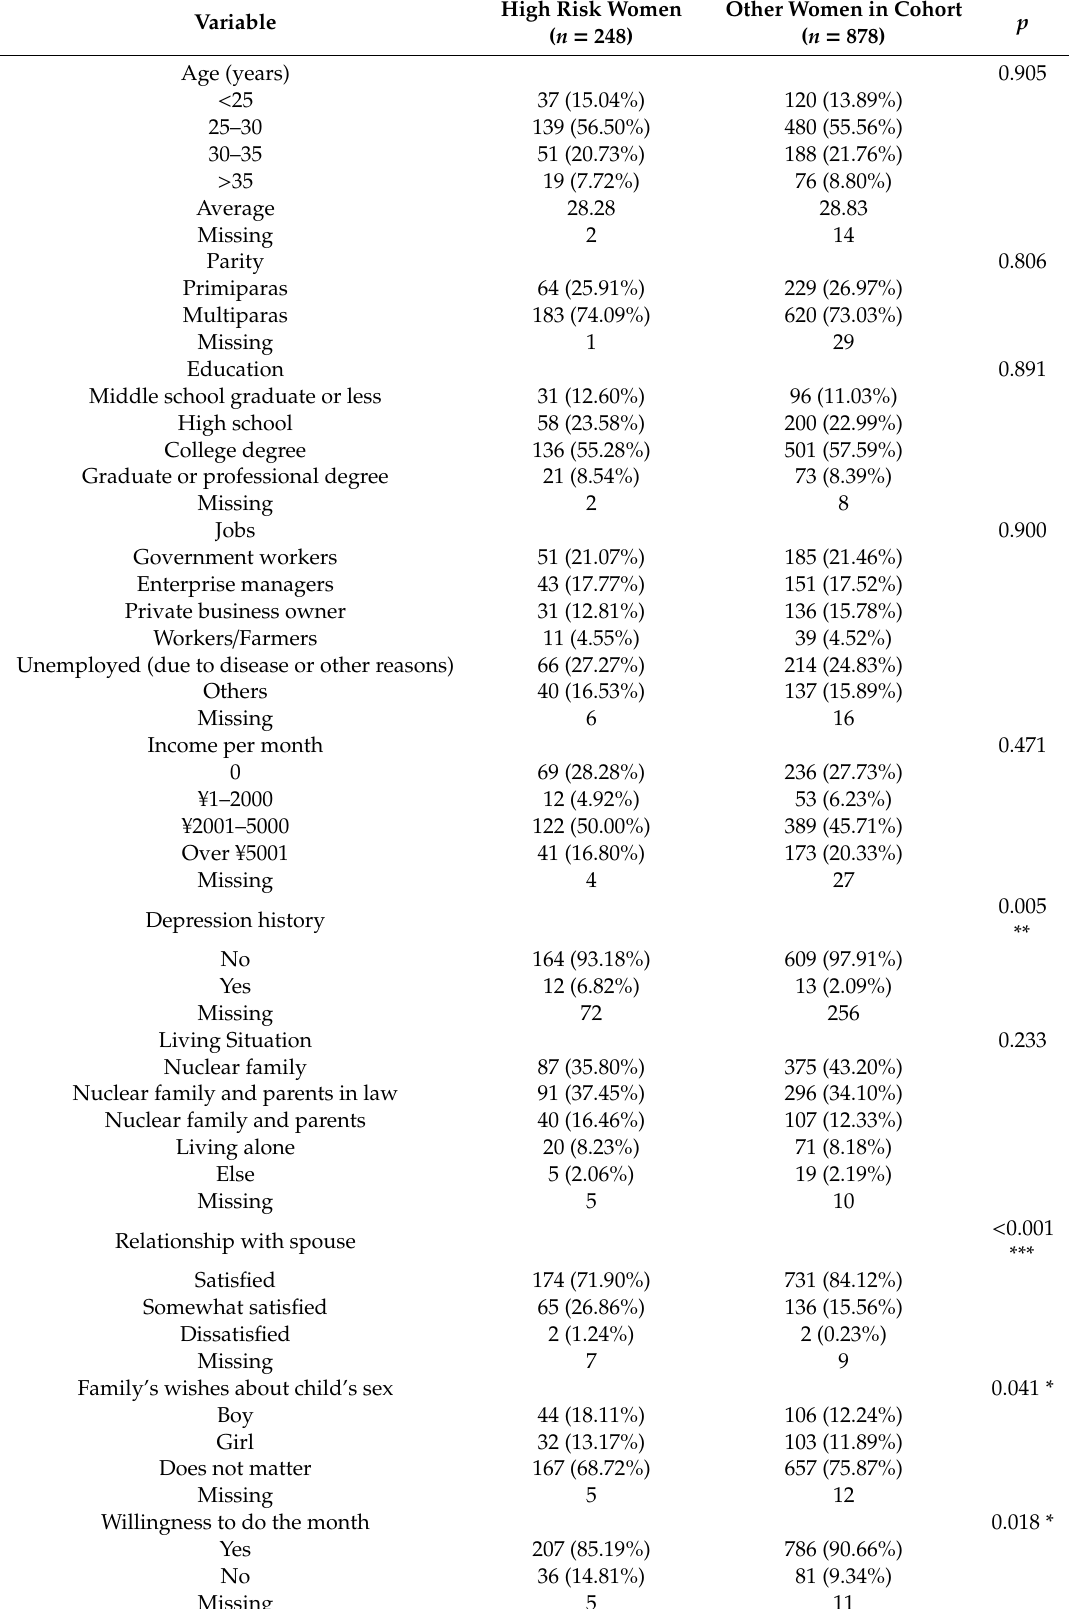
Table 1. Participant profile ( n =